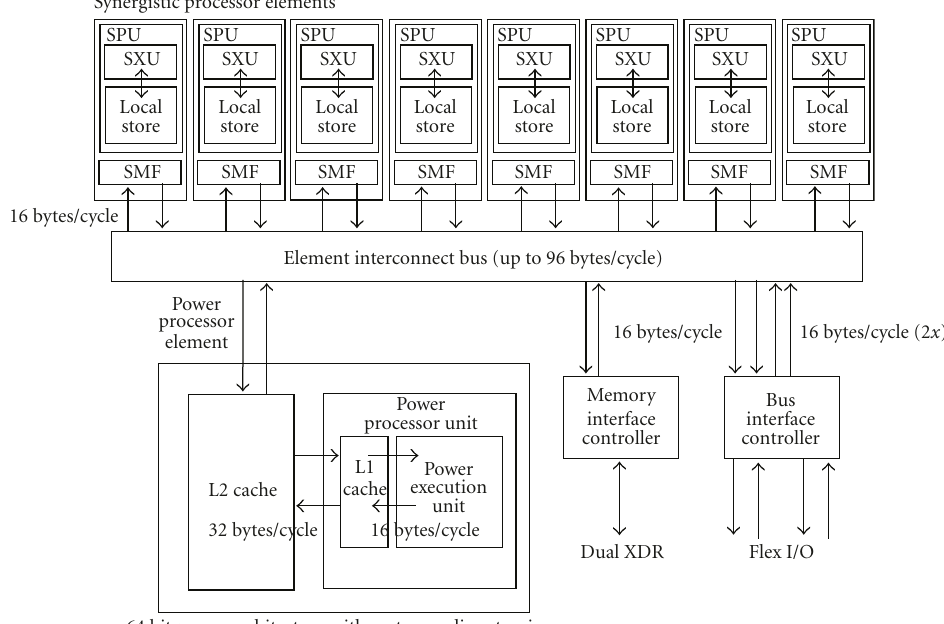
Figure 1: Cell BE high-level architecture